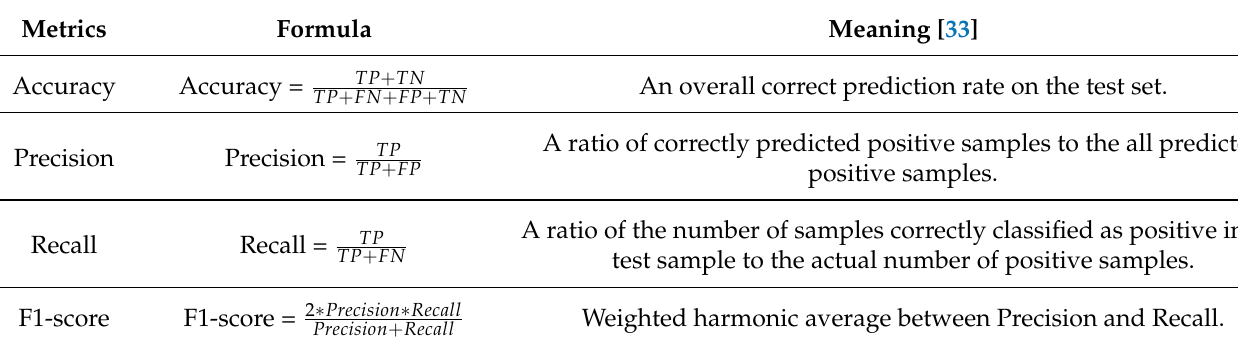
Table 2. Evaluation metrics methods in the RTS fault